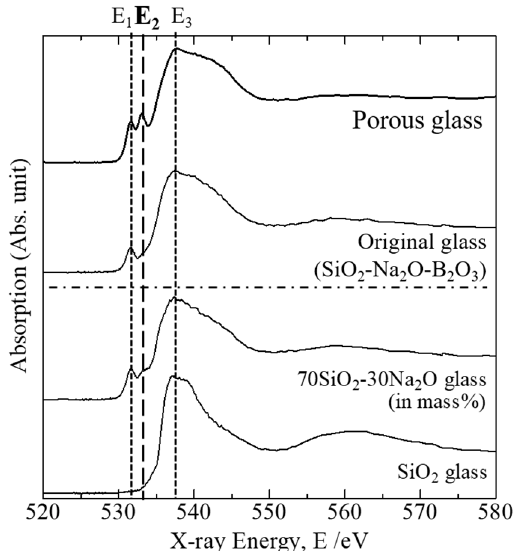
Figure 3. Oxygen K-edge X-ray absorption near-edge structure (XANES) spectra of porous glass and original sodium borosilicate glass observed in partial electron yield (PEY) mode. The spectra for SiO 2 and 70% SiO 2 –30 Na 2 O (in mass %) glasses are provided as reference materials for non-bridging oxygen and bridging oxygen ions.